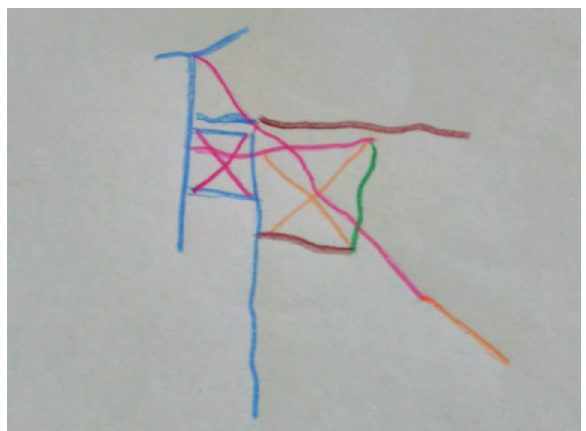
Figure 1. Patient’s copy of Rey Complex Figure showing lack of planning, perseveration, visuoconstructional and visuomotor difficulties.